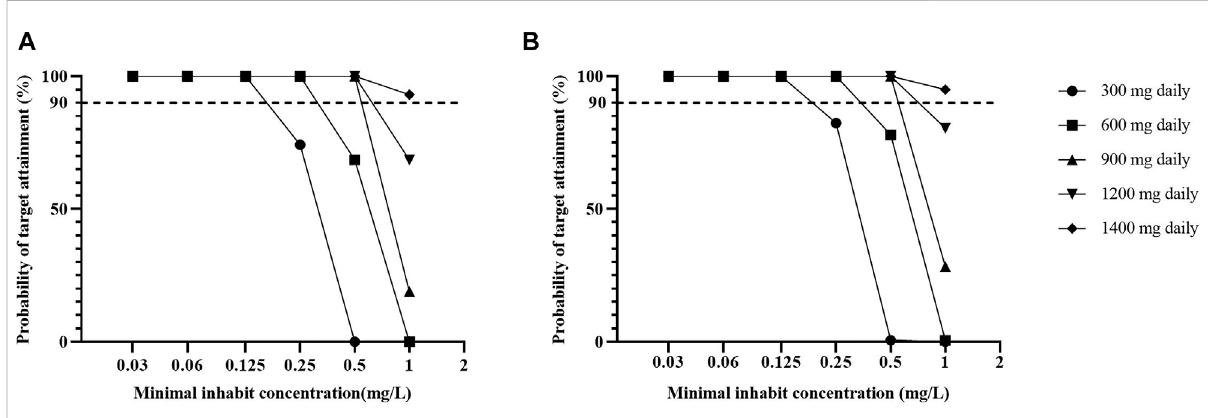
respectively based on the AUC 0 – 24h /MIC of 125 in this study (A) and the 119 previously reported (B) . Note: The previously reported target of AUC 0 – 24h /MIC 119 (Srivastava et al., 2017) was identi fi ed using the MGIT assay (Becton Dickinson, Franklin Lakes, NJ) to identify MIC in hollow fi ber infection model as the reference for comparison. Abbreviations: PTA, probability of target attainment; AUC 0-24h : 0- to 24-h area under the concentration-time curve; MIC, minimum inhibitory